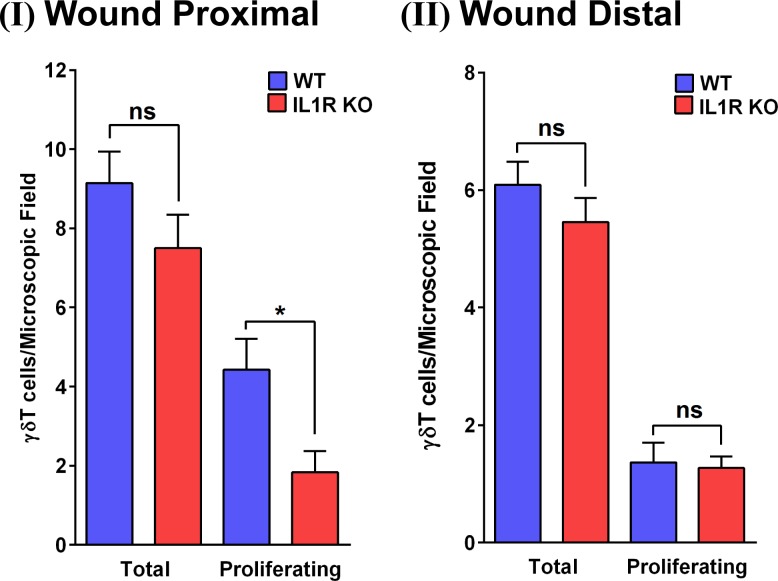
Quantification of proliferating γδT-cells.The number of total γδT-cells and proliferating γδT-cells based on the images in Figure 3—figure supplement 1. Panel I shows quantitation of a region proximal to the wound bed. Panel II shows quantitation of a region 2 cm distal from the wound bed.